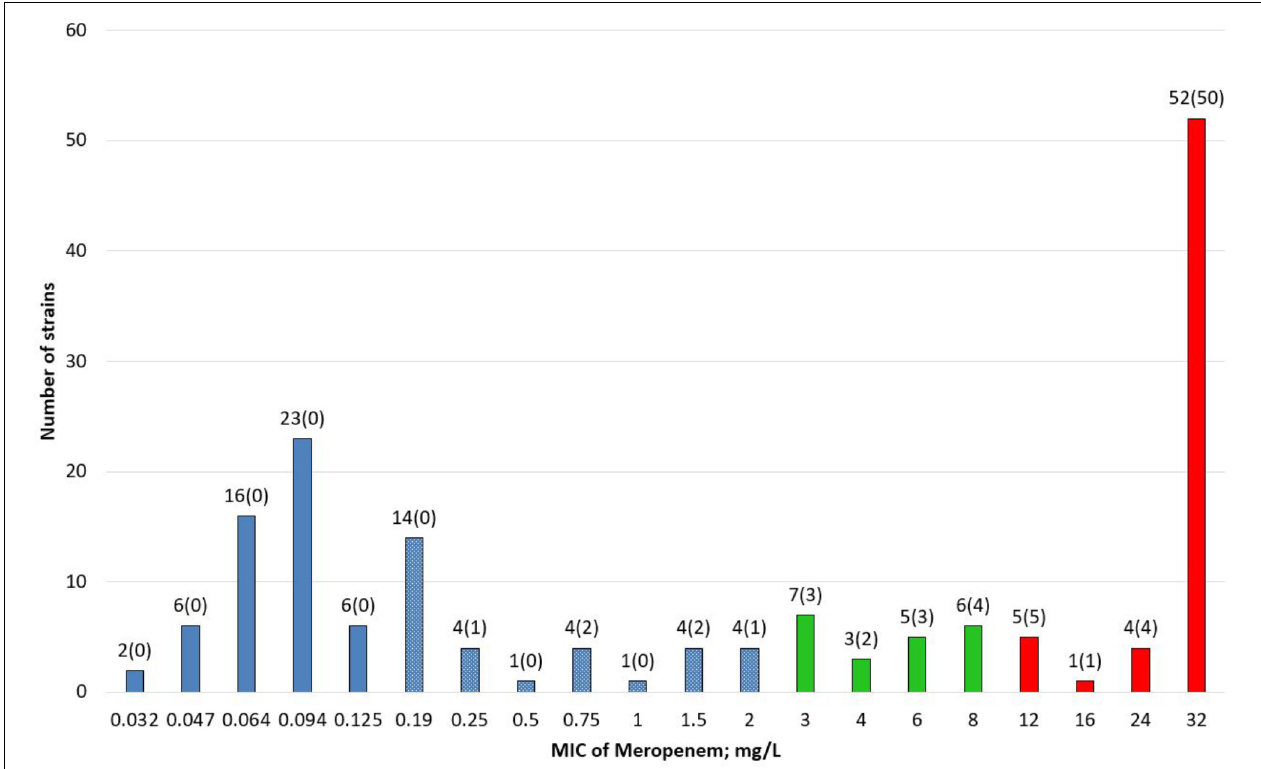
FIGURE 1 | Distribution of Meropenem MIC values in screening-positive Klebsiella pneumoniae strains ( n = 168). Blue boxes: susceptible strains ( ≤ 2 mg/L); blue boxes with white dotes: susceptible above screening cut-off ( > 0.125– ≤ 2 mg/L); green boxes: susceptible, increased exposure ( > 2–8 mg/L); red boxes: resistant ( > 8 mg/L). Number of strains (number of strains with carbapenemase gene).